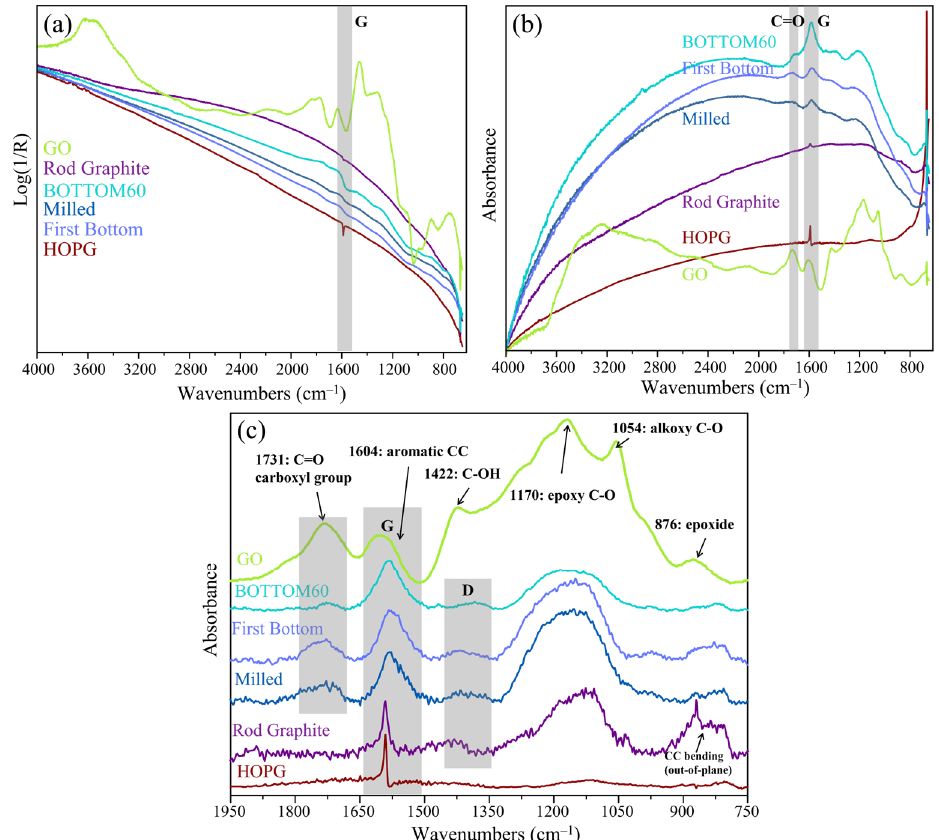
Figure 7. FTIR spectra of HOPG, ROD, GO, and GNPs samples at different preparation steps: ( a ) Specular reflection (SR) spectra; ( b ) absorption spectra from SR after Kramers–Kronig transformation; and ( c ) absorption spectra after baseline correction in the region 1950–750 cm − 1 .